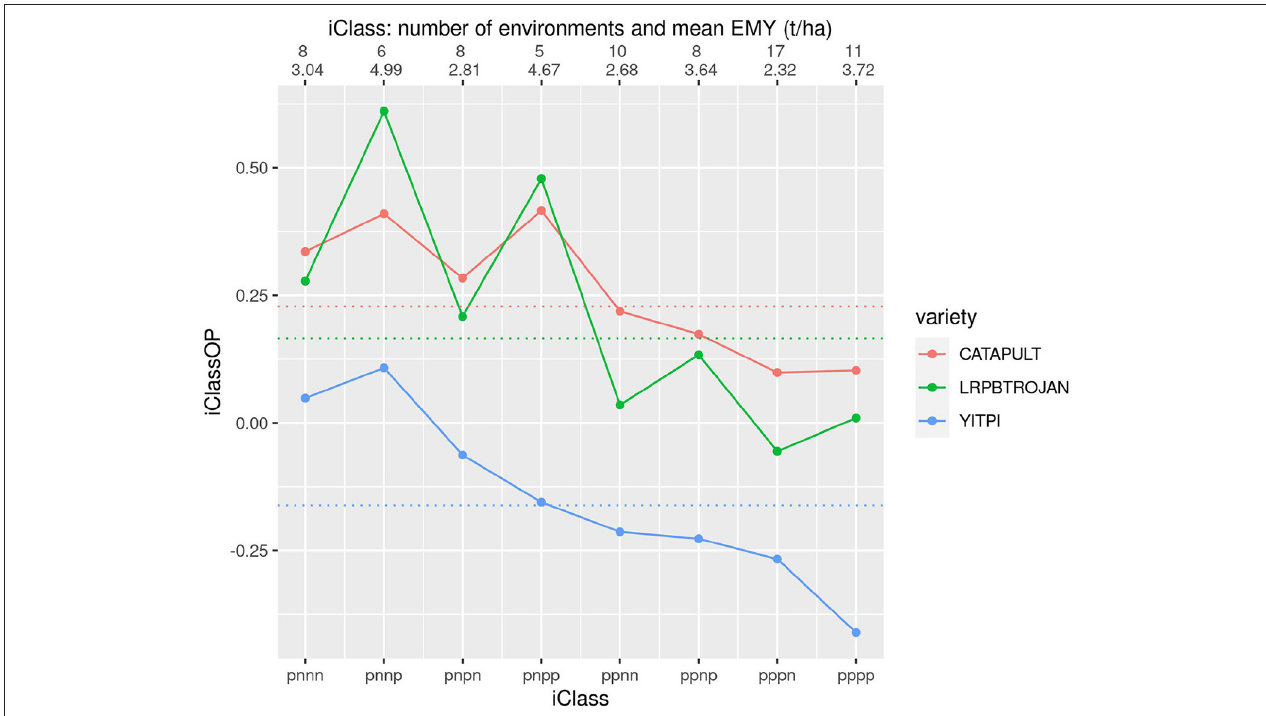
FIGURE 7 | iClass interaction plot for the three varieties CATAPULT, LRPBTROJAN and YITPI. The points and solid lines that join them correspond to iClassOP and the dotted horizontal lines correspond to the OP measure of Smith and Cullis (2018). The axis at the top shows the number of environments in each iClass and the mean of the associated environment mean